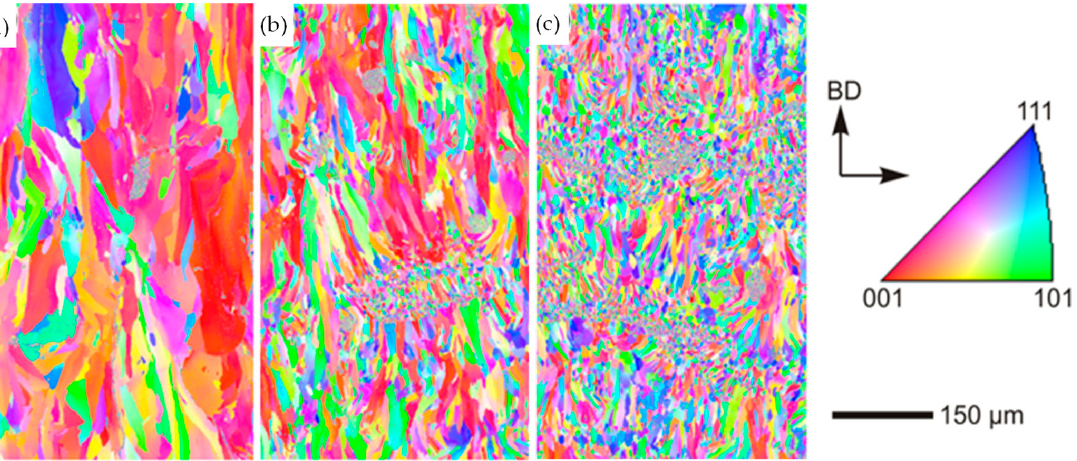
Figure 13. EBSD maps of the LPBF ‐ 7075 Al alloy with different concentrations of Si additions: ( a ) 0 wt.%; ( b ) 2 wt.%; ( c ) 4 wt.%. Maps are oriented along the build direction. Reproduced with permis ‐ sion from Elsevier [48].